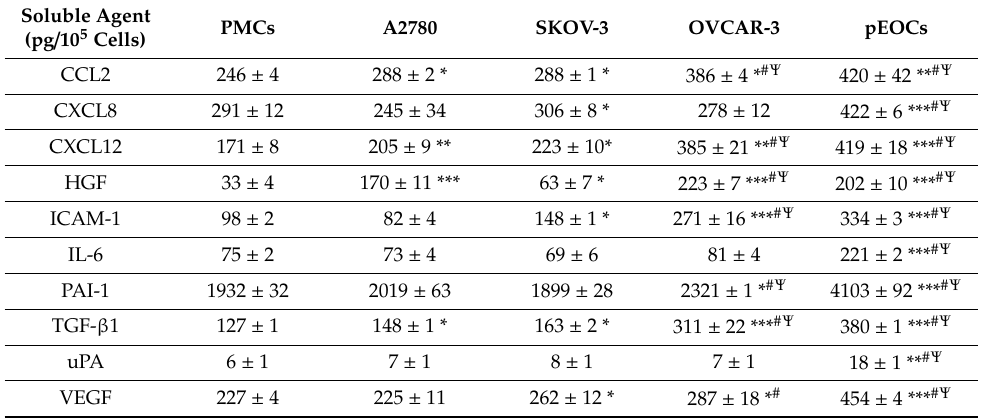
Measurements were performed using the conditioned media generated by eight cultures of PMCs isolated from di ff erent donors and by eight separate cultures of cancer cells. The results are expressed as the mean ± SEM. *, p < 0.05 vs. PMCs; **, p < 0.01 vs. PMCs; ***, p < 0.001 vs. PMCs; # , p < 0.05 vs. A2780; Ψ , p < 0.05 vs. SKOV-3. pEOCs, primary epithelial ovarian cancer